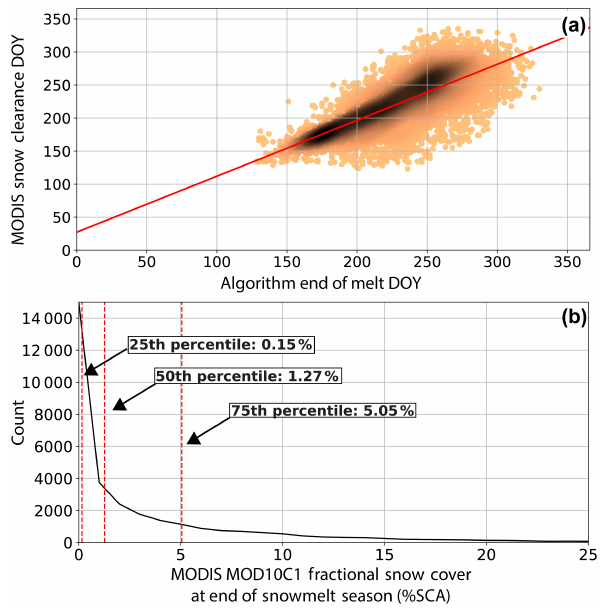
Figure 4. (a) Comparison of MODIS MOD10C1 (Hall and Riggs, 2016) and algorithm-derived end of the snowmelt season days of year, with darker areas indicating high point densities. We find strong agreement between the snowmelt end dates derived from both datasets (slope = 0 . 85, R 2 = 0 . 58, n = 34468) despite the presence of outliers. (b) MODIS snow-covered area fraction at the algorithm-derived end of the snowmelt season. This shows, for ex- ample, that over all algorithm-determined snowmelt end dates, the median SCA was 1.27% and SCA was below 5% in the majority of cases. Areas with snowmelt periods of less than 20 days are re- moved from this analysis.